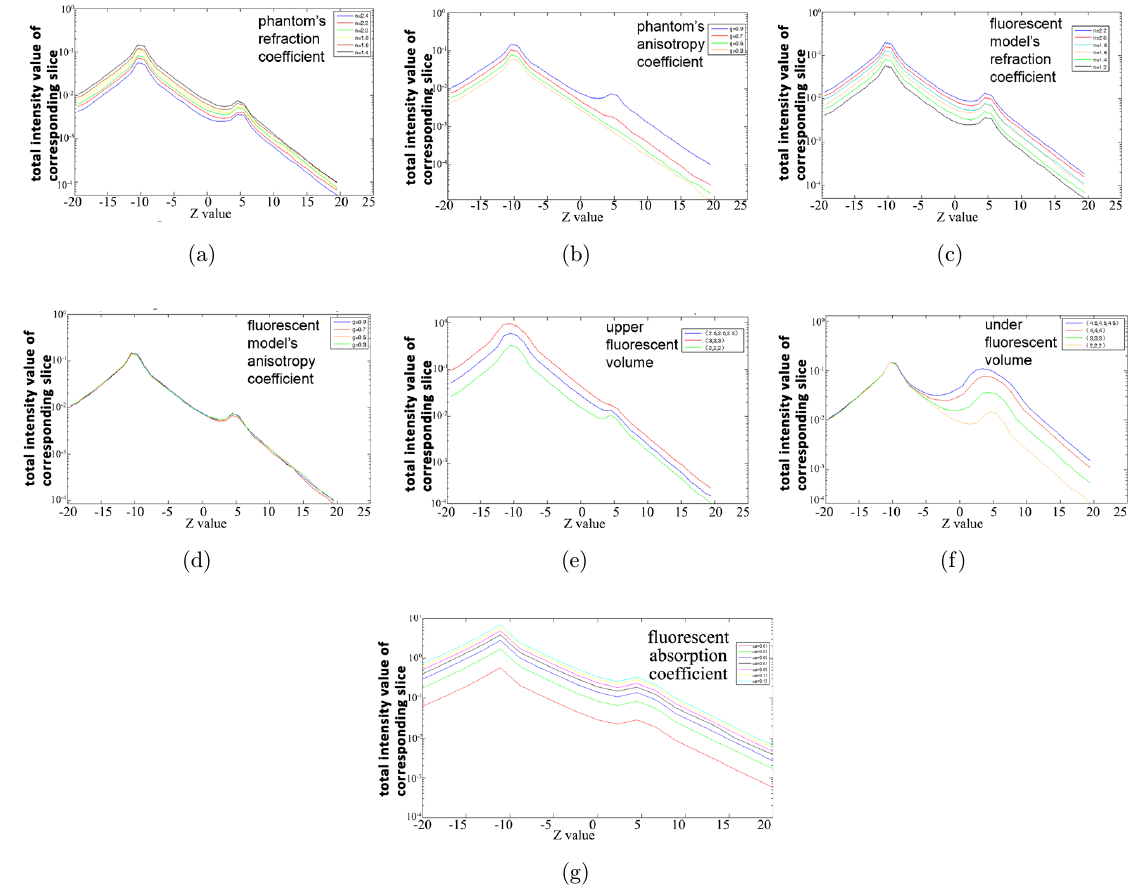
Fig. 9. Exponential law of total °uorescence intensity in each slice. (a) when the phantom's refraction coe±cient changes, (b) when the phantom's anisotropy coe±cient changes, (c) when the °uorescent volume's refraction coe±cient changes, (d) when the °uorescent model's anisotropy coe±cient changes, (e) when the higher °uorescent volume changes, (f) when the lower °uorescent volume changes and (g) when the absorption coe±cient